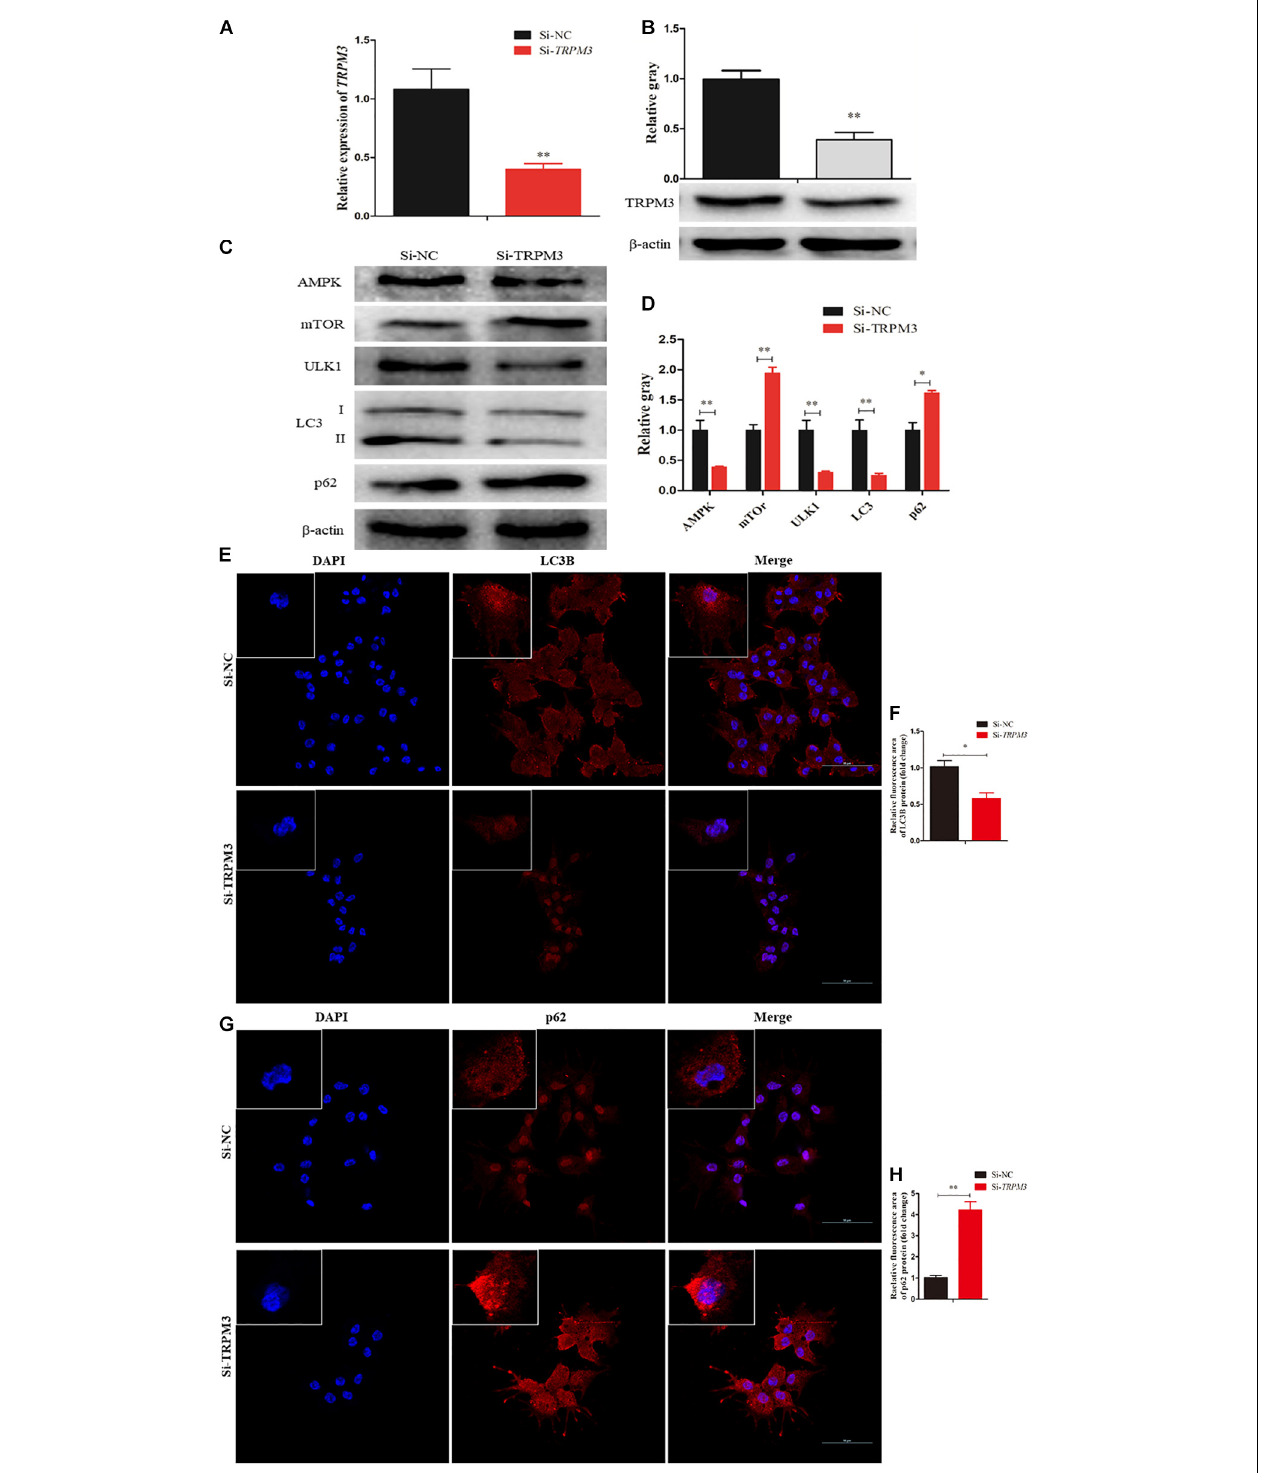
FIGURE 9 | Transient receptor potential melastatin 3 (TRPM3) promotes granulosa cell (GC) autophagy. (A, B) The mRNA and protein expressions of TRPM3 were detected after transfection of Si-TRPM3. (C, D) The protein levels of TRPM3/AMP-activated protein kinase (AMPK)/ULK1 pathway [AMPK, mammalian target of rapamycin (mTOR), ULK, LC3-II, and p62] were detected after transfection of Si-TRPM3. β -actin was used as a reference gene. (E, F) Immunofluorescence analysis was performed to test the fluorescence intensity of LC3B after TRPM3 silencing. (G, H) Immunofluorescence analysis was performed to test the fluorescence intensity of p62 after TRPM3 silencing. Replications = 3. Data are presented as mean ± SE; * P < 0.05 and ** P < 0.01.